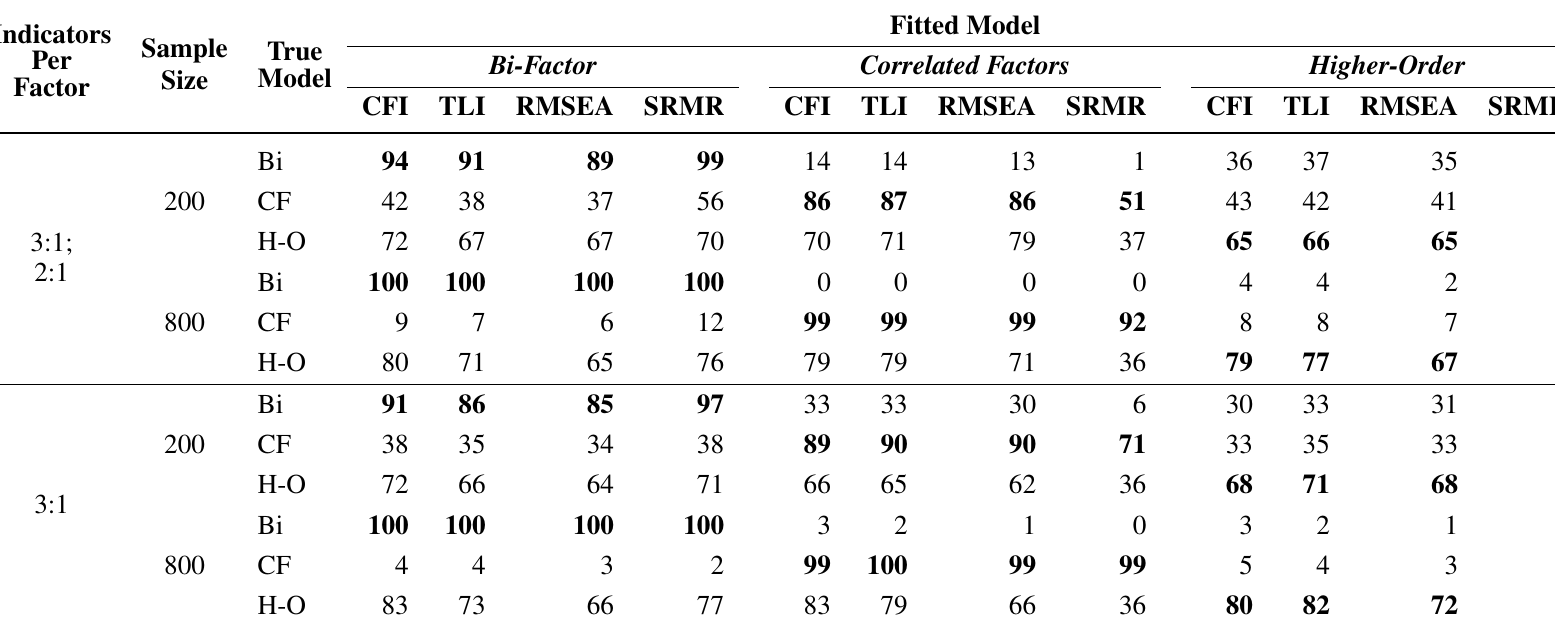
Table 2. Percentage of solutions selected by each approximate fit index for each cell of the study design (rounded to nearest whole